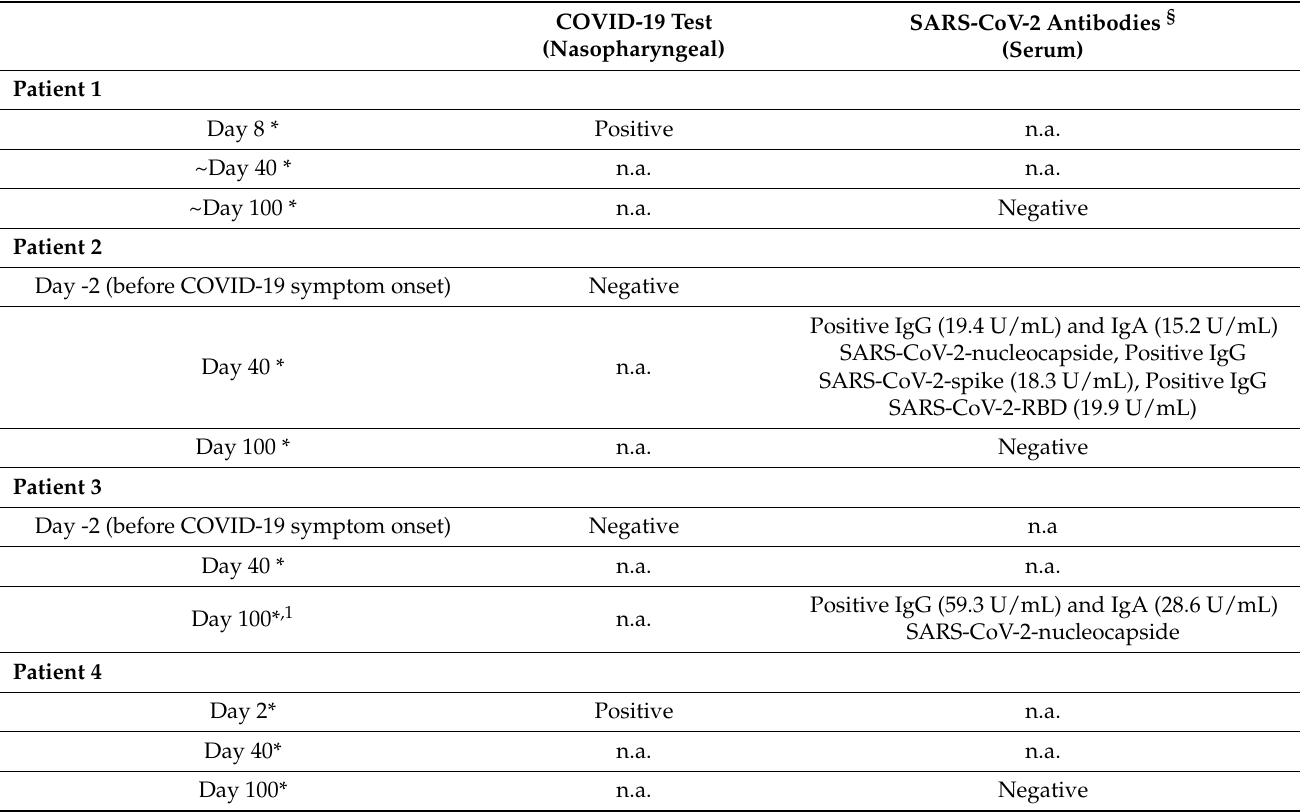
Table 3. Test results for COVID-19/SARS-CoV-2